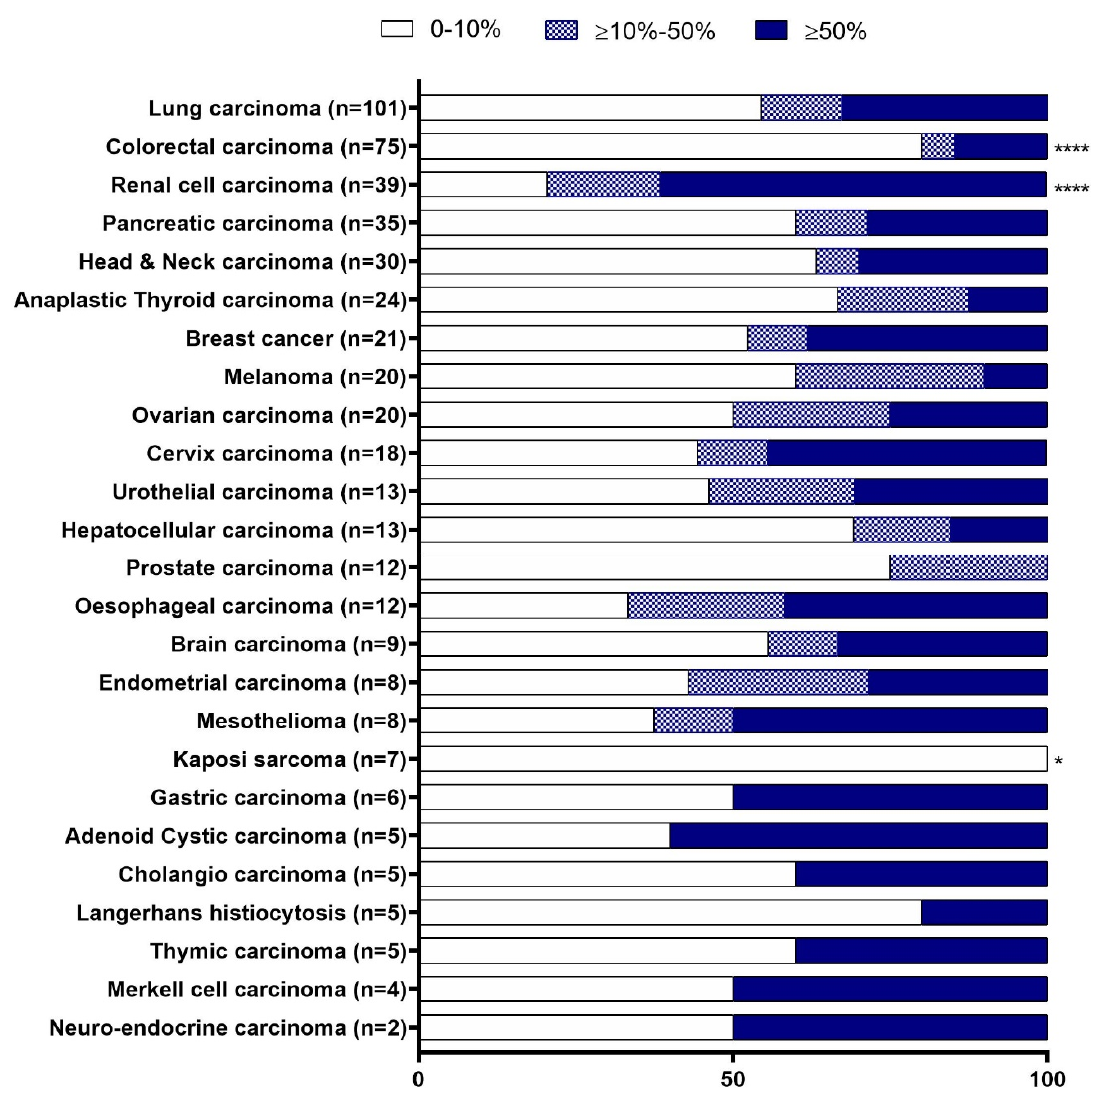
Figure 1. Proportion of CD70 staining among solid tumour types. CD70 staining was categorised in 3 different groups based on the percentage of tumour cells staining positive: expression levels ranging from 0 to 10% (empty bars); between 10 to 50% (patterned bars); and, expression levels above 50% (solid bars). * p < 0.05, **** p < 0.0001. For statistics, tumour types with N < 5 were not considered in the statistical analysis.